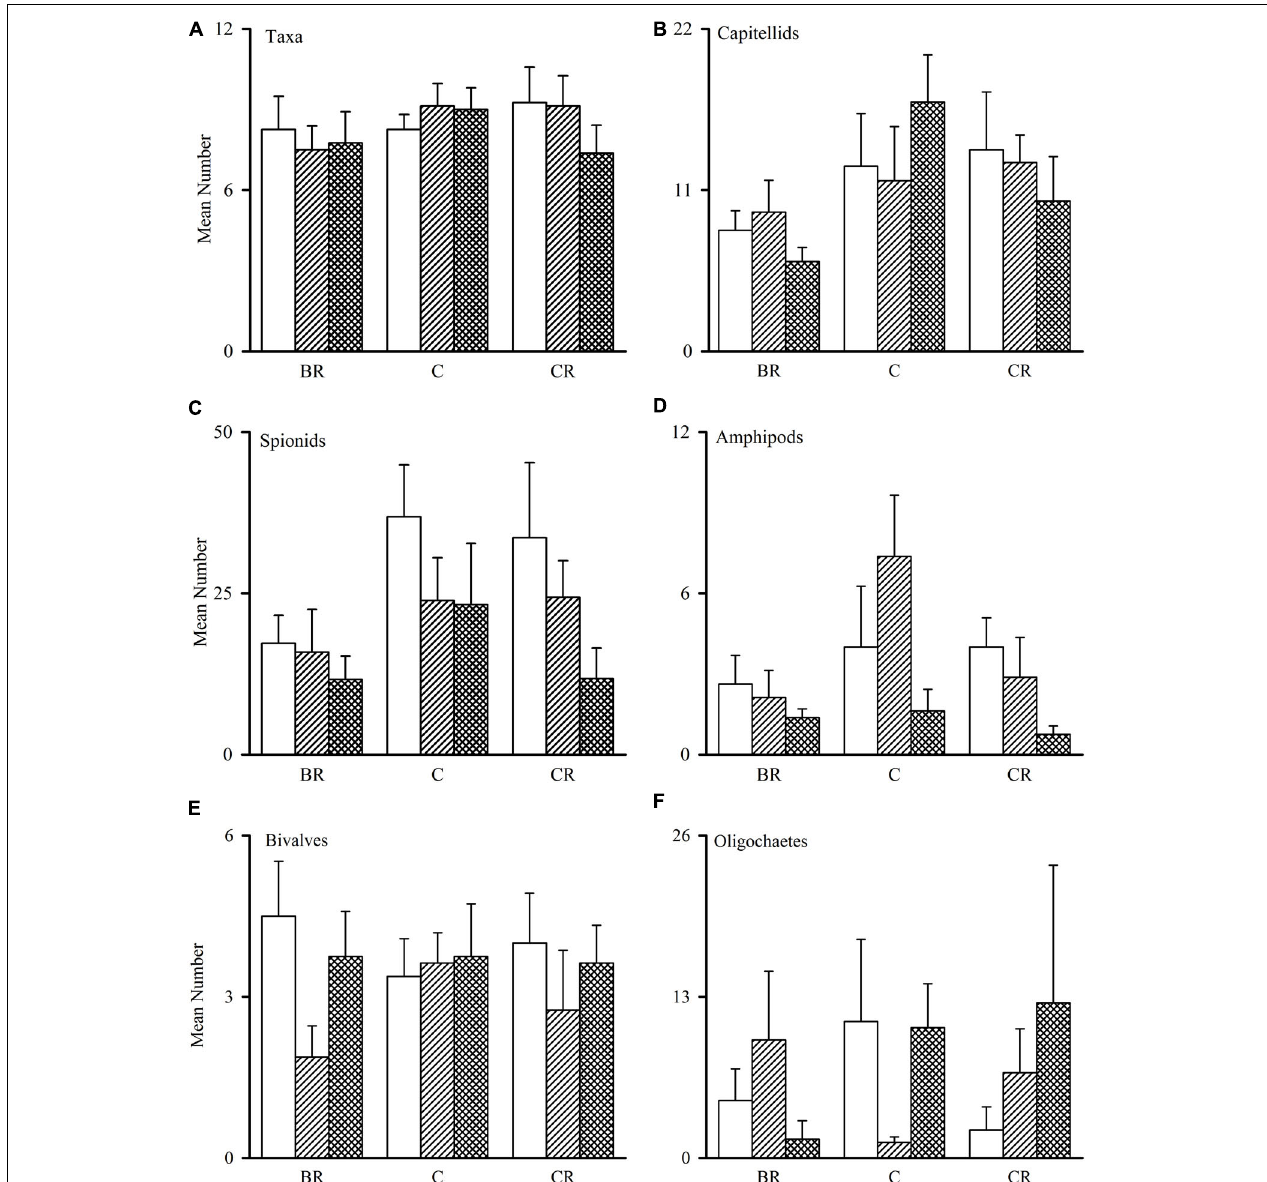
FIGURE 2 | Tambourine Bay macrofauna after 2 weeks, mean ( SE .; n = 4 plots). Panel (A) numbers of all taxa and abundances of (B) capitellids, (C) spionids, (D) amphipods, (E) bivalves, and (F) oligochaetes in heavily shaded plots with black roofs (BR), lightly shaded plots with clear roofs (CR) or unshaded control plots (C), when provided with added nutrients (white bars), no nutrients (linear hatched bars) or the associated procedural control (crosshatched bars).